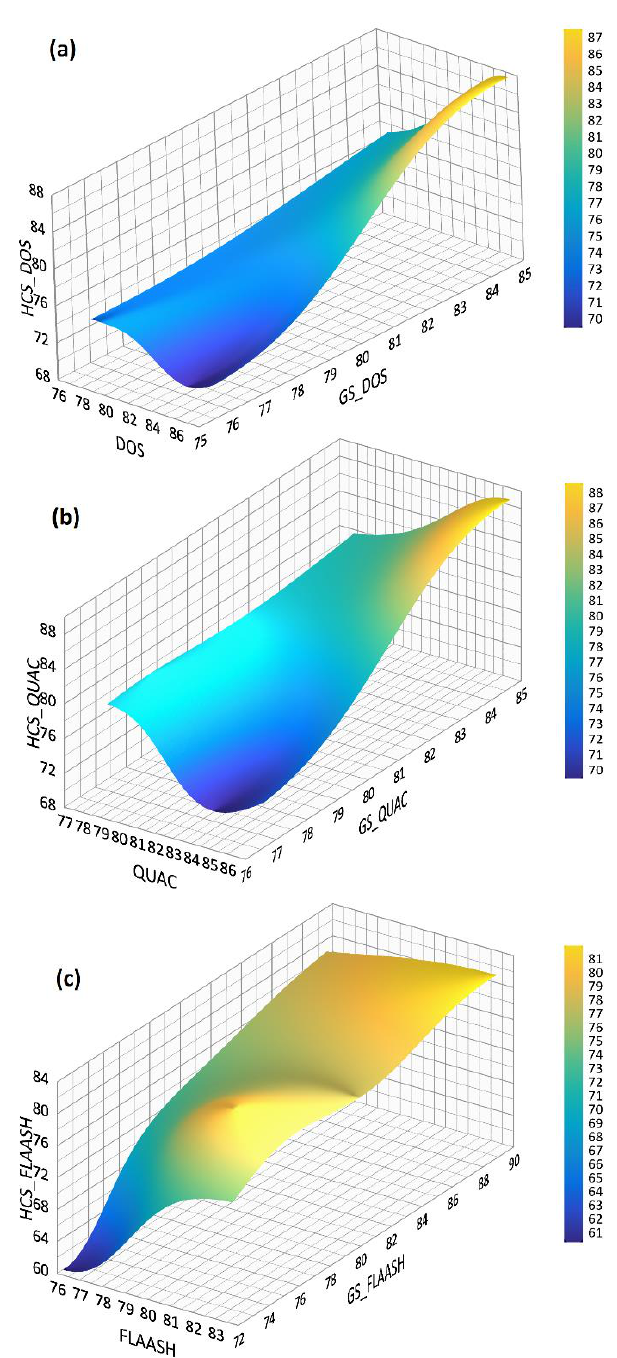
Figure 9. Overall-accuracy-based assessment of the performance of pansharpened vs. non-sharpened classifications. The 3D surface summarizes the OA from all three rule sets for ( a ) DOS vs. GS_DOS vs. HCS_DOS, ( b ) QUAC vs. GS_ QUAC vs. HCS_ QUAC, and ( c ) FLAASH vs. GS_FLAASH vs. HCS_FLAASH.